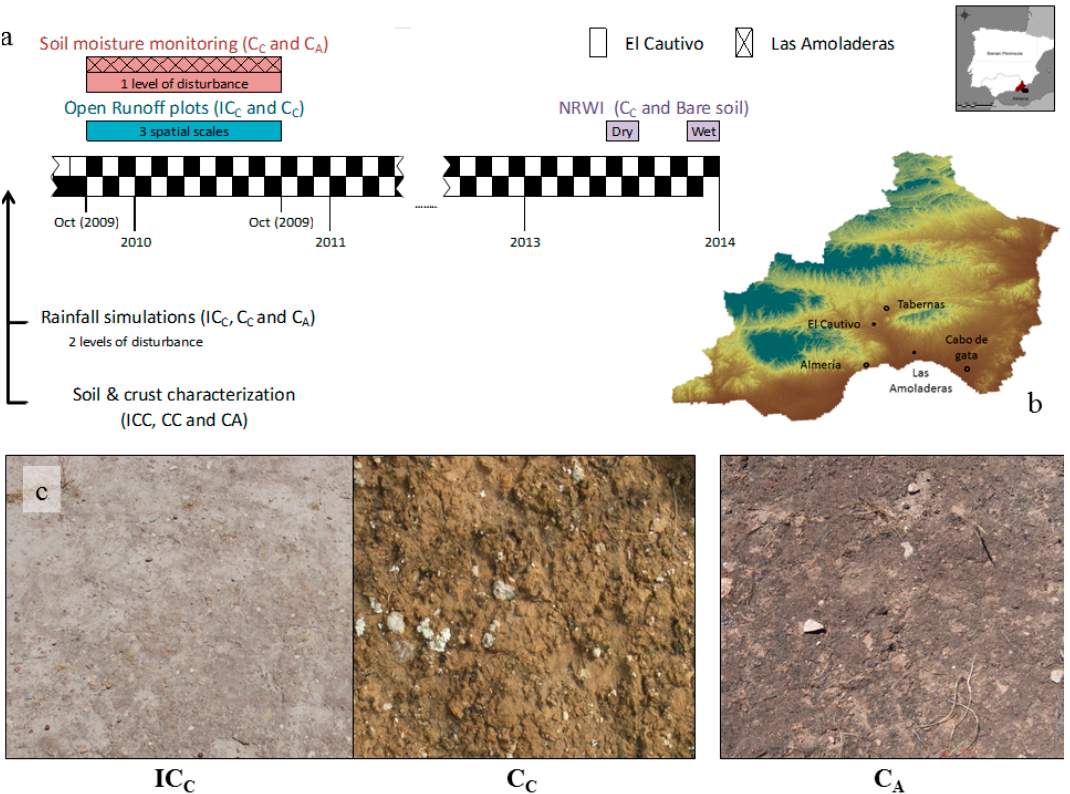
Figure 1. Sampling and monitoring schedule ( a ); location of the study sites ( b ); photos of the